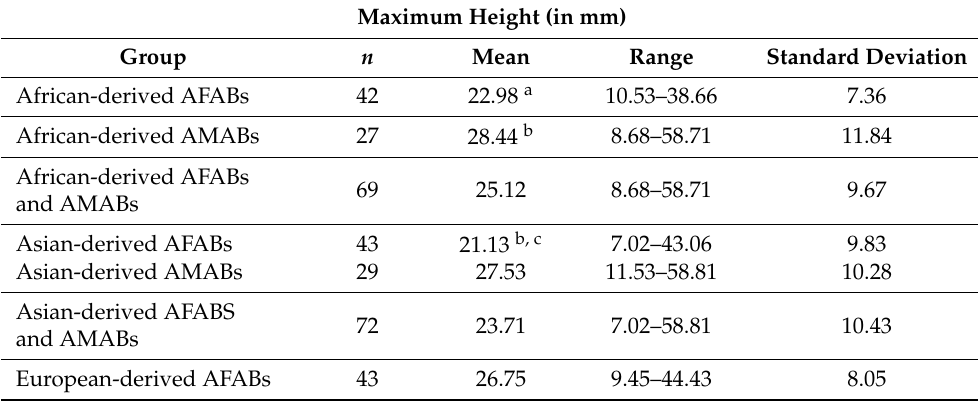
Table 5. Descriptive statistics for the frontal sinus maximum height by population affinity and assigned